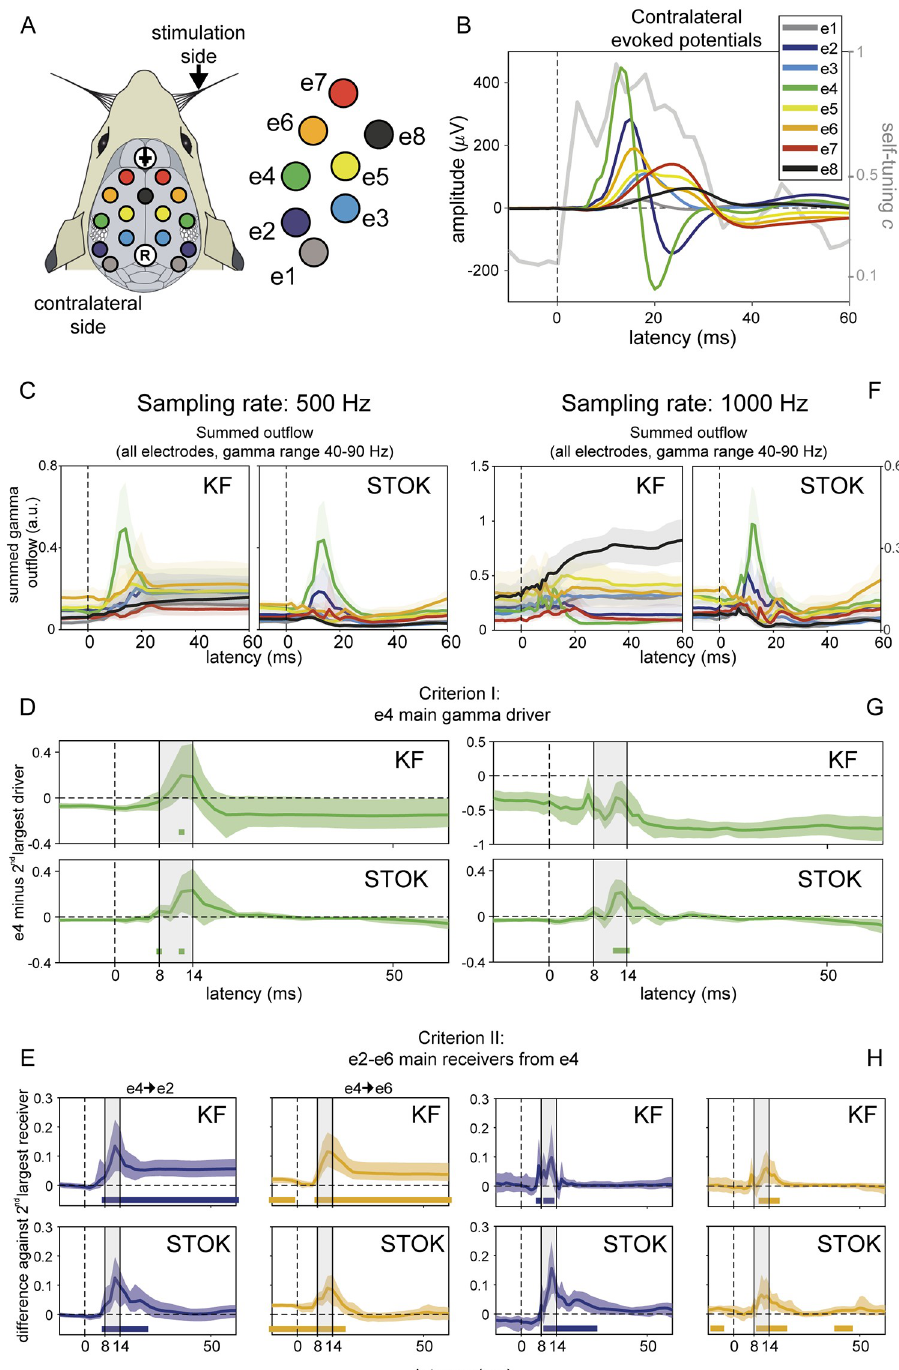
Fig 3. Results in benchmark rat EEG. (A) Layout of the multi-electrode grid used for recordings with the electrode and label codes used for all the plots. (B) Grand-average somatosensory evoked potentials at electrodes contralateral to stimulation ( n = 10) showing the sequence of maximum voltage peaks, starting at e4 and propagating to e2-6. The gray line shows the evolution of the self-tuning memory parameter of the STOK filter. (C) Summed outflow in the gamma range (40–90 Hz) from all electrodes at the sampling rate of 500 Hz, revealing higher temporal precision with STOK filtering. (D-E) Criterion I and II: STOK and KF similarly identified e4 as the main driver at expected latencies (top panel), however, STOK recovered more temporally localized dynamics and evoked patterns in the total inflow of gamma activity from e4 to the two main targets e2-e6 (bottom panel). Colored squares at the bottom of each